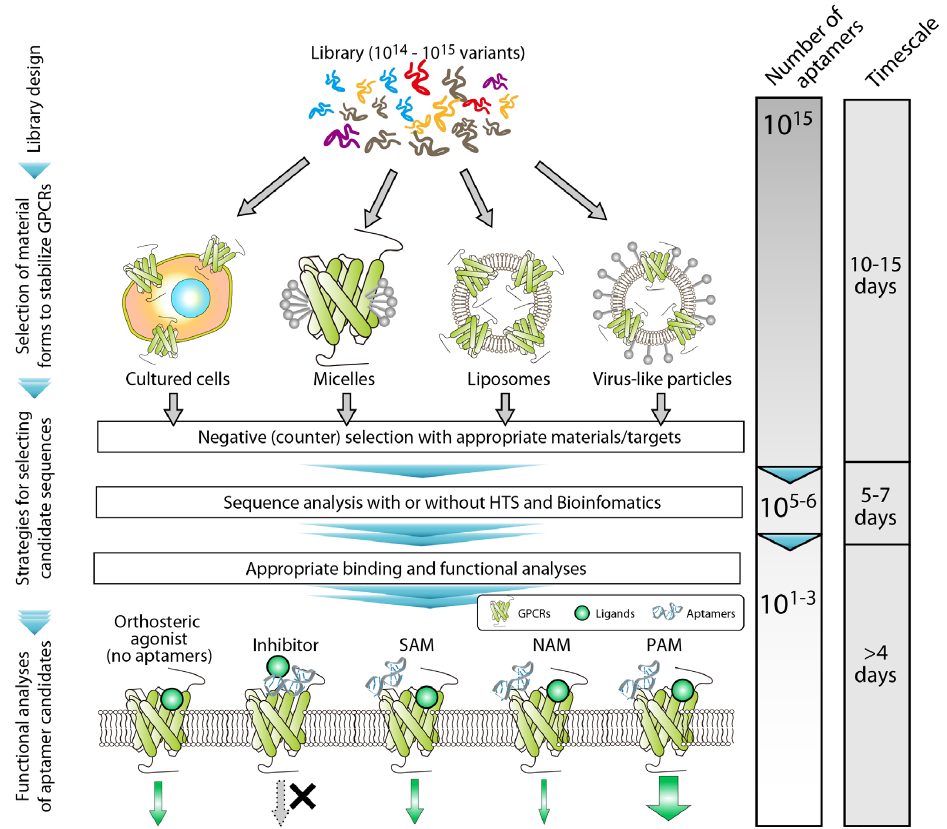
Figure 1. SELEX targeting GPCRs. Several studies successfully identified aptamers targeting GPCRs by using various selection materials and strategies of sequence analyses. The previous studies showed aptamers acting as inhibitors, silent allosteric modulators (SAMs), negative allosteric modulators (NAMs), and positive allosteric modulator (PAM) agonists. The expected change (decrease) in the on the right side of the schema. number of sequences during SELEX and the average time required for each process are shown on the right side of the schema.